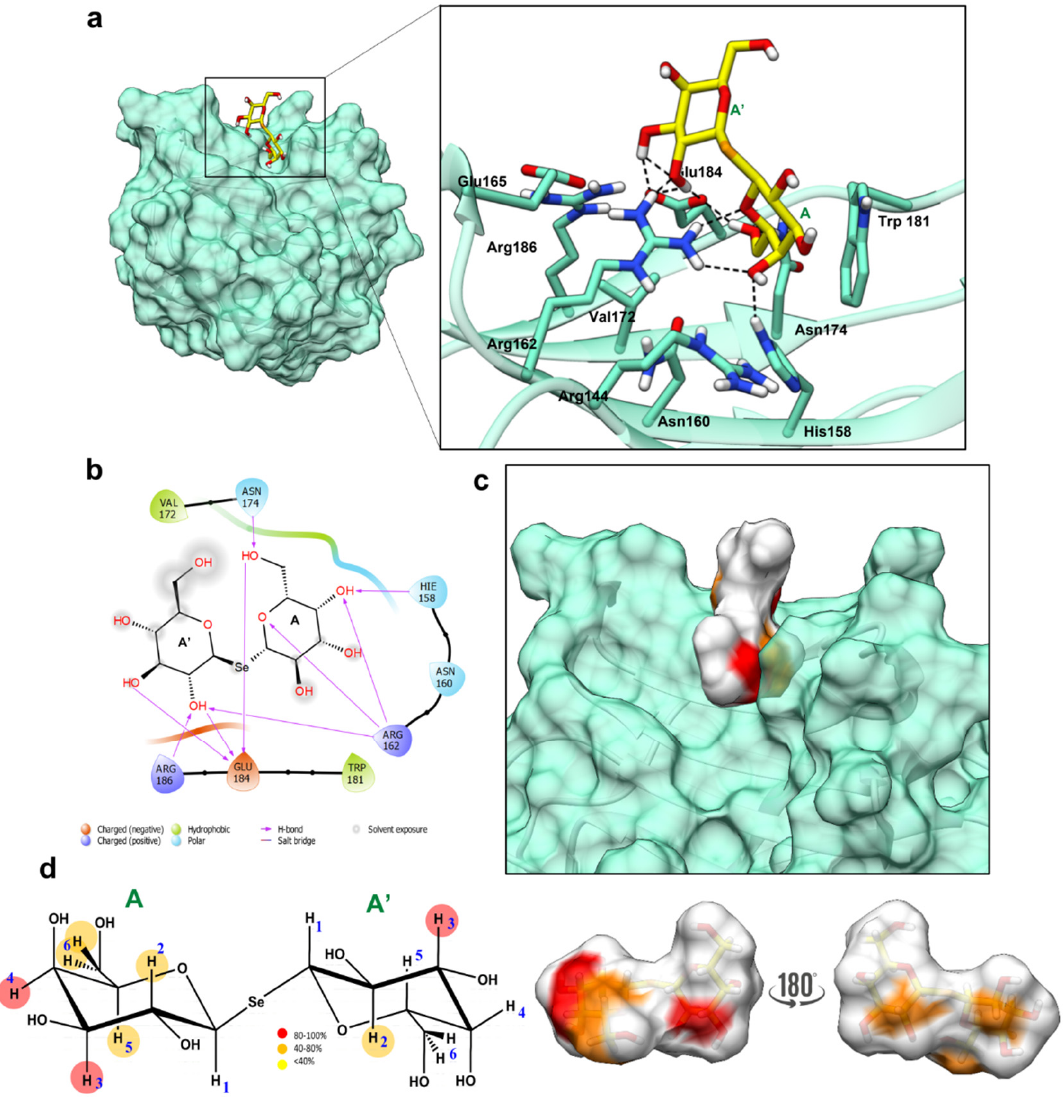
Figure 6. Interaction between Gal-3 CRD and SeDG. ( a ) The 3D model of the Gal-3 CRD —SeDG. Close- up view of a representative frame from the most populated MD cluster with the main residues involved in the binding depicted as sticks. ( b ) Two-dimensional plot representing the interactions between the SeDG and Gal-3 CRD binding pocket residues. ( c ) Gal-3 CRD /SeDG 3D complex as derived by the combination of the MD and STD-NMR results. The ligand surface is colored according to the STD enhancements. ( d ) Interacting epitope map of SeDG derived from STD-NMR data on the left and 3D representation of SeDG in the bioactive conformation with the molecular surface colored according to the STD enhancements.